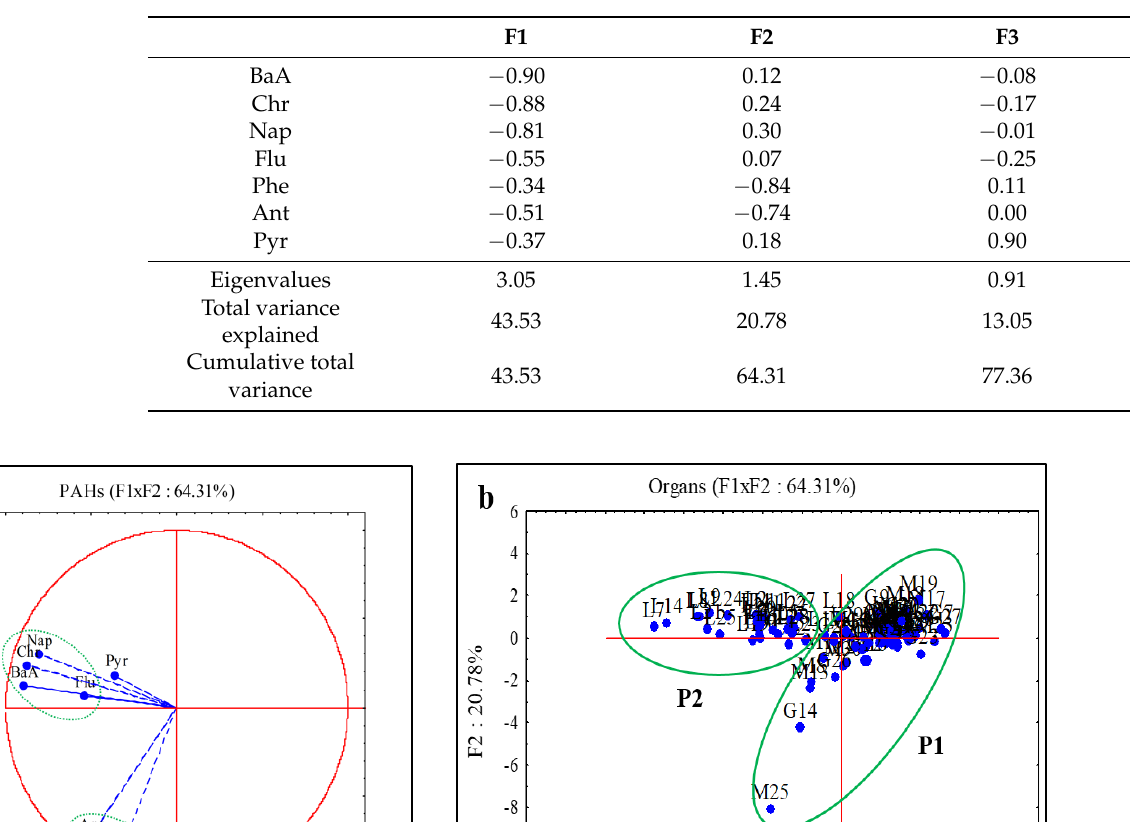
Table 3. Eigenvalues, total variances and correlation between variables and axes.